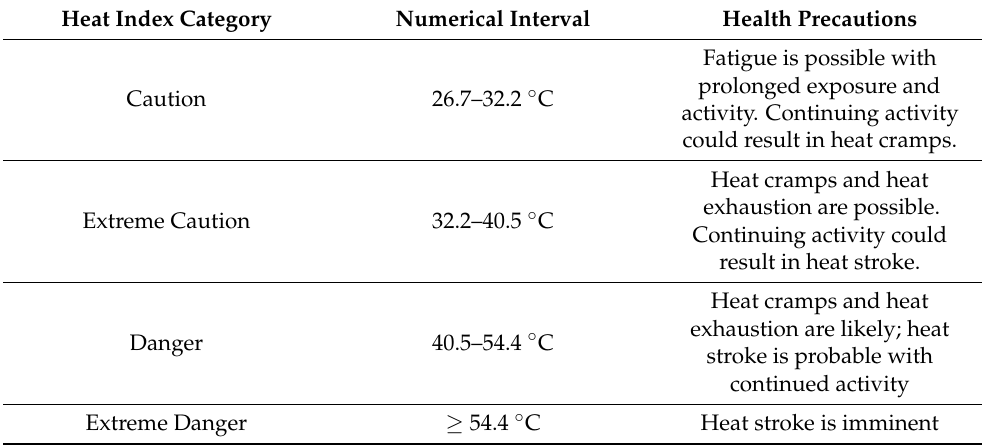
Table 3. Heat index categories and health